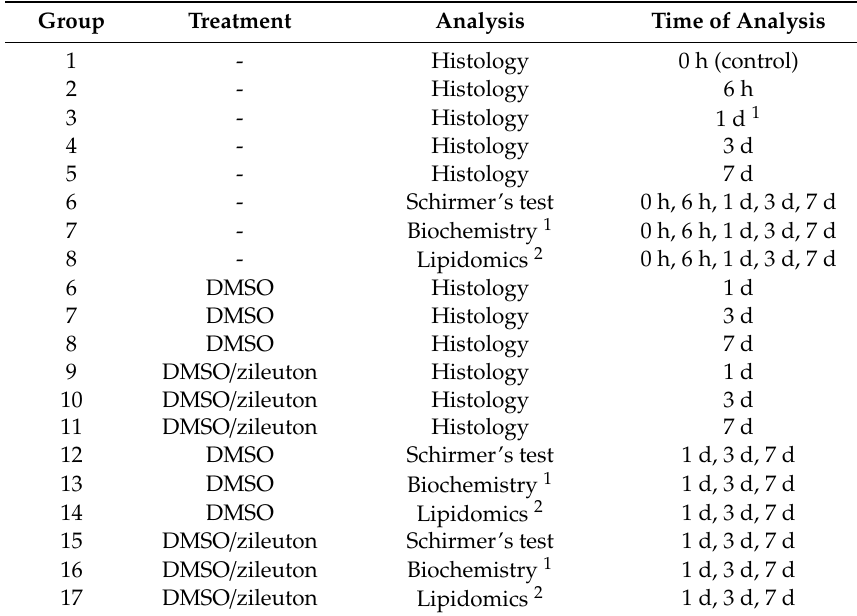
Table 1. Parameters of the experimental